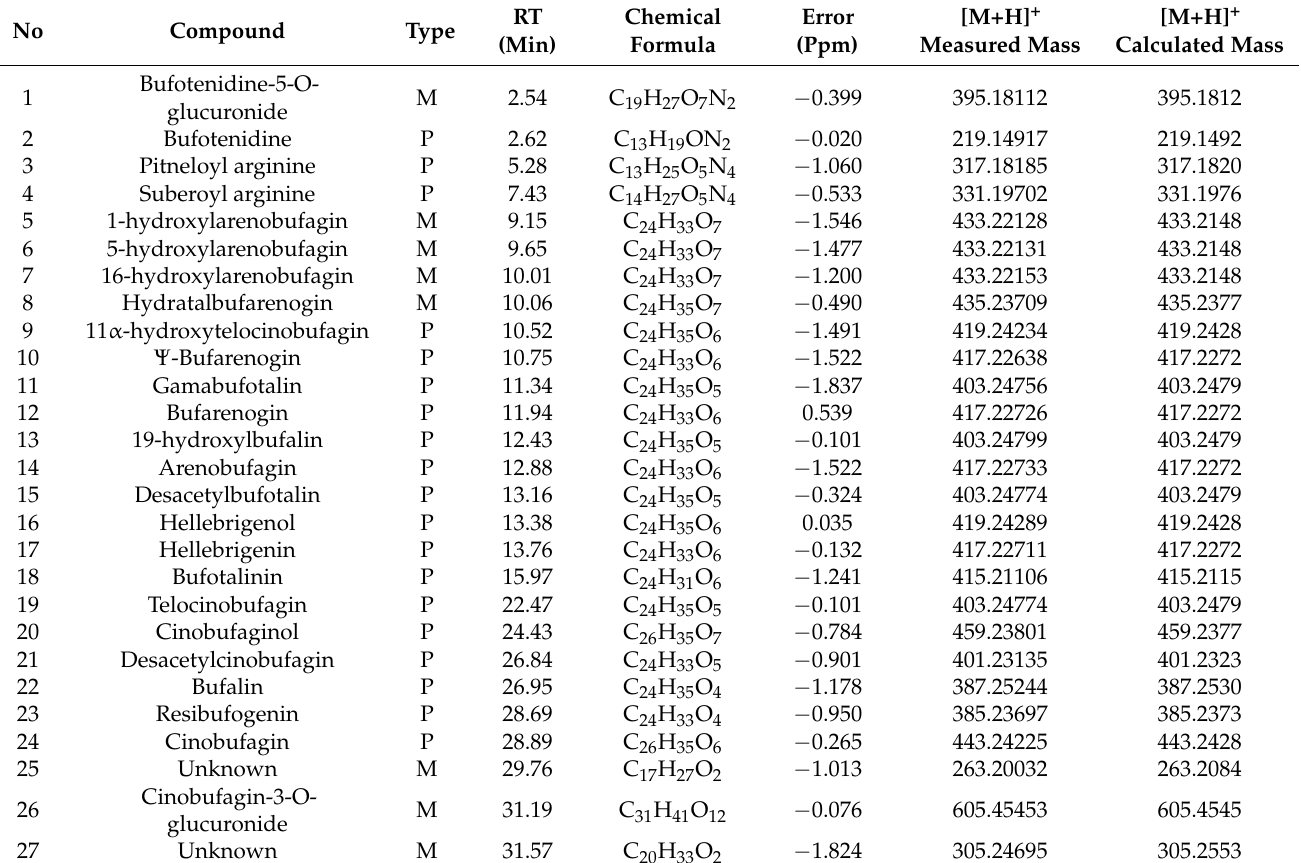
Table 1. UHPLC-HR-Q-Exactive Orbitrap MS data of 27 compounds from toad venom extract detected in rat